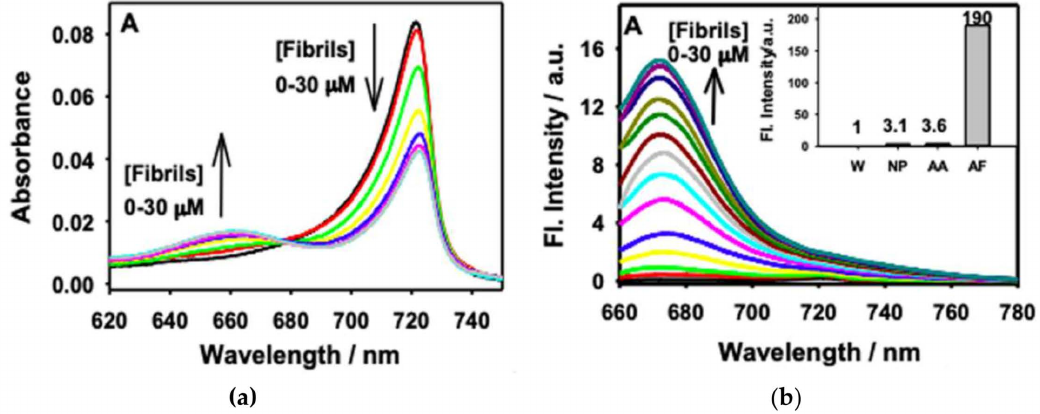
Figure 13. Changes in the absorption ( a ) and fluorescence ( b ) spectra of 54 (0.34 µ M) upon addition of insulin fibrils (0–30 µ M). Inset: Bar diagram for the change in emission intensity of 54 in water and different forms of insulin protein: W—water, NP—native protein, AA—amorphous aggregates, AF—amyloid fibrillar aggregates. Adapted from [49].